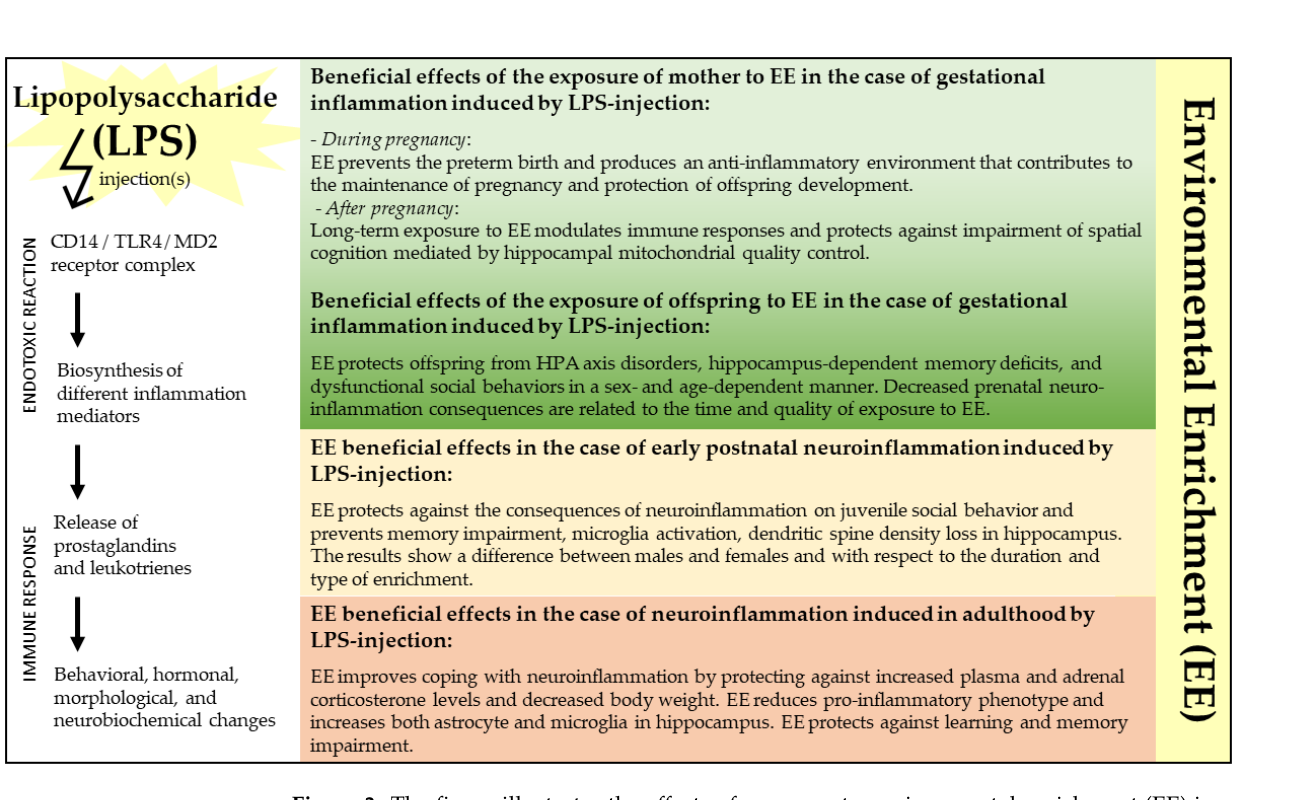
Figure 3. The figure illustrates the effects of exposure to environmental enrichment (EE) in coun- teracting lipopolysaccharide (LPS)-induced neurotoxicity across the lifespan. CD14: cluster